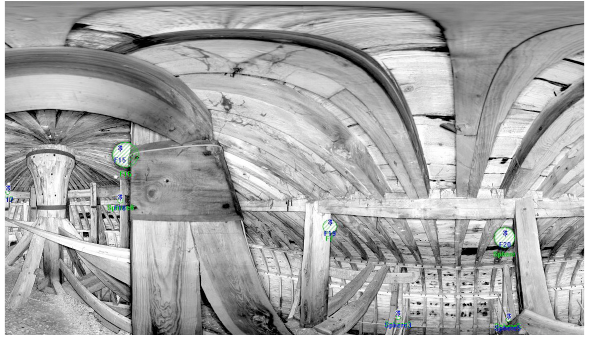
Figure 5. The recognition of the targets using FARO Scene.